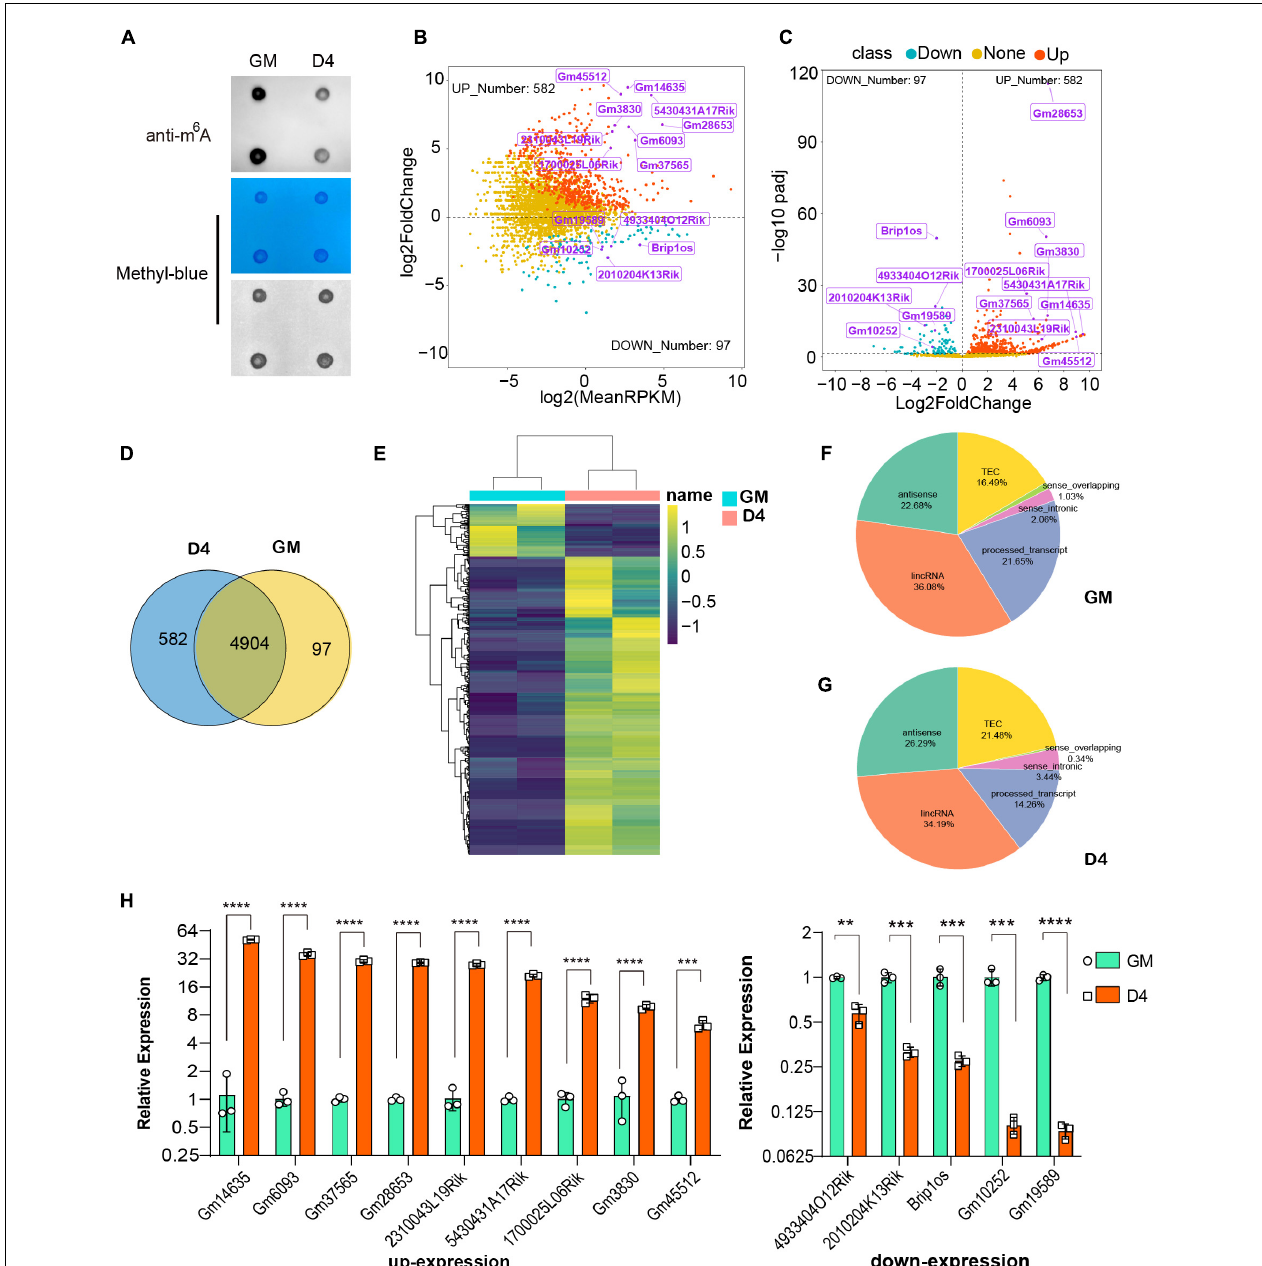
FIGURE 1 | Dynamic profile of lncRNAs in myoblasts and differentiated myotube. (A) RNA dot blot assay of m 6 A methylation levels of C2C12 myoblasts in GM and D4. (B) MA plot shows the relationship of expression abundance and fold changes of lncRNAs in myoblasts (GM) and myotube (D4). log2 (MeanRPKM) represents gene expression values, log2Fold Change represents the fold change of lncRNAs at D4 compared to GM. Red dots represent 582 significantly up-regulated lncRNAs at D4 in relation to GM, adjusted P ≤ 0.05; Green dots, represent 97 significantly down-regulated lncRNAs at D4 in relation to GM, adjusted P ≤ 0.05; Yellow dots represent lncRNA without significantly differential expression, adjusted P > 0.05. Top differentially expressed lncRNAs were marked in purple. (C) The volcano plot shows significantly differentially expressed lncRNAs at GM and D4. Red dots represent 582 significantly up-regulated lncRNAs at D4, adjusted P ≤ 0.05; Green dots, represent 97 significantly down-regulated lncRNAs at D4, adjusted P ≤ 0.05; Yellow dots represent lncRNA without significantly differential expression, adjusted P > 0.05. Top differentially expressed lncRNAs were marked in purple. (D) The Venn diagram shows 97 and 582 significantly differentially expressed lncRNAs in GM and D4, and 4904 lncRNAs without significant difference between GM and D4. (E) The heatmap shows significantly differentially expressed lncRNAs in GM and D4. Yellow color represents up-regulation in D4, while green color represents down-regulation. Row represents genes, column represents samples, and each cell represents expression value. (F) Pie chart show the gene types of lncRNAs up-regulated in GM. (G) Pie chart show the gene types of lncRNAs up-regulated in D4. (H) Quantitative real-time reverse transcription PCR (qRT-PCR) validated top differently expressed lncRNAs in developing muscle cells. RPKM: Reads Per Kilobase per Million mapped reads. adjusted P: adjusted p -value; Data are presented as Mean ± SD; p value: ** p < 0.01, *** p < 0.001, **** p < 0.0001.